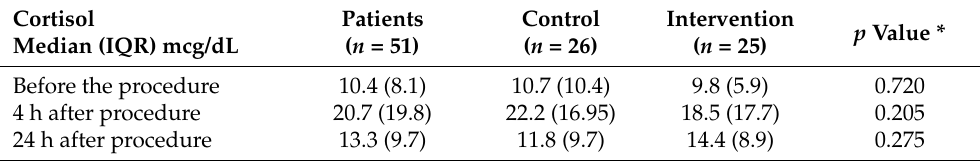
Table 4. Cortisol Values. IQR = interquatile range; * Mann–Whitney test.